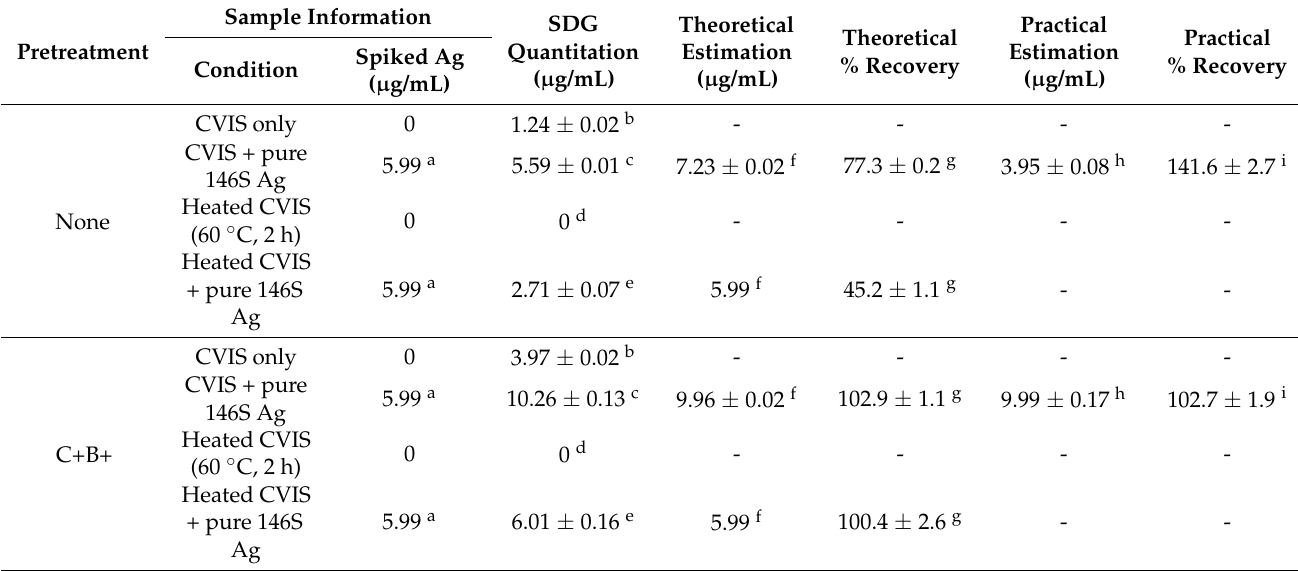
Table 2. A spiking test result by SE-HPLC for the validation of the pretreatment method for